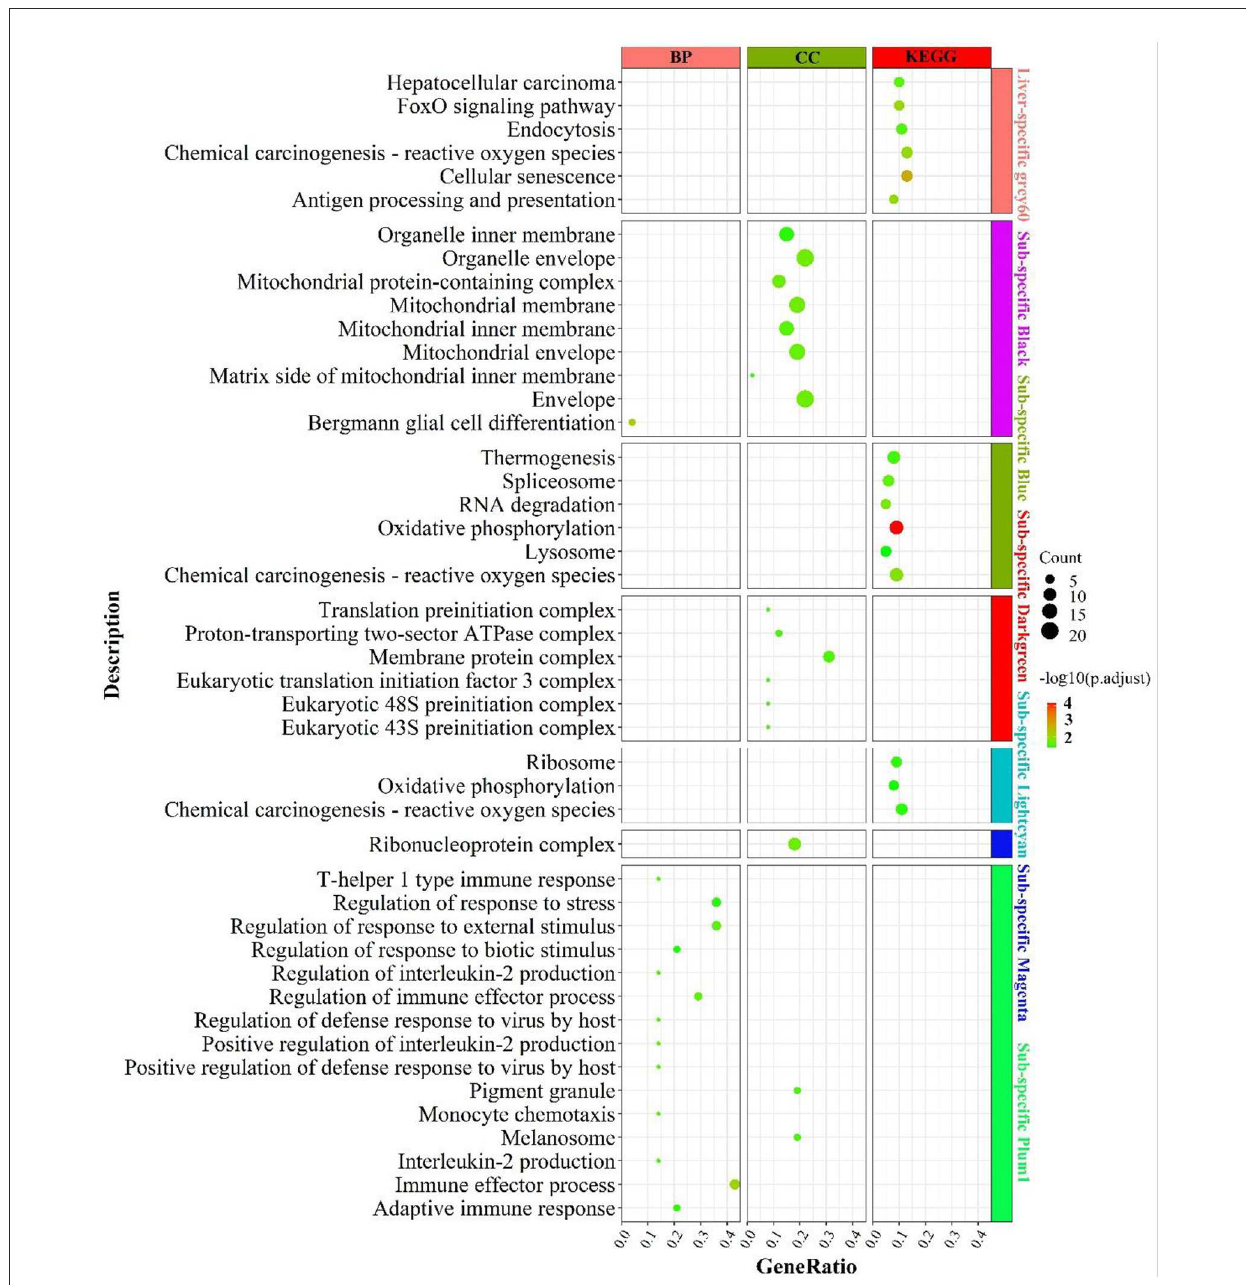
FIGURE6 Enrichment analysis for consensus or liver-/fat-specific modules in LF regulatory axis. The dot size and color represented enriched gene numbers and the enriched significance.